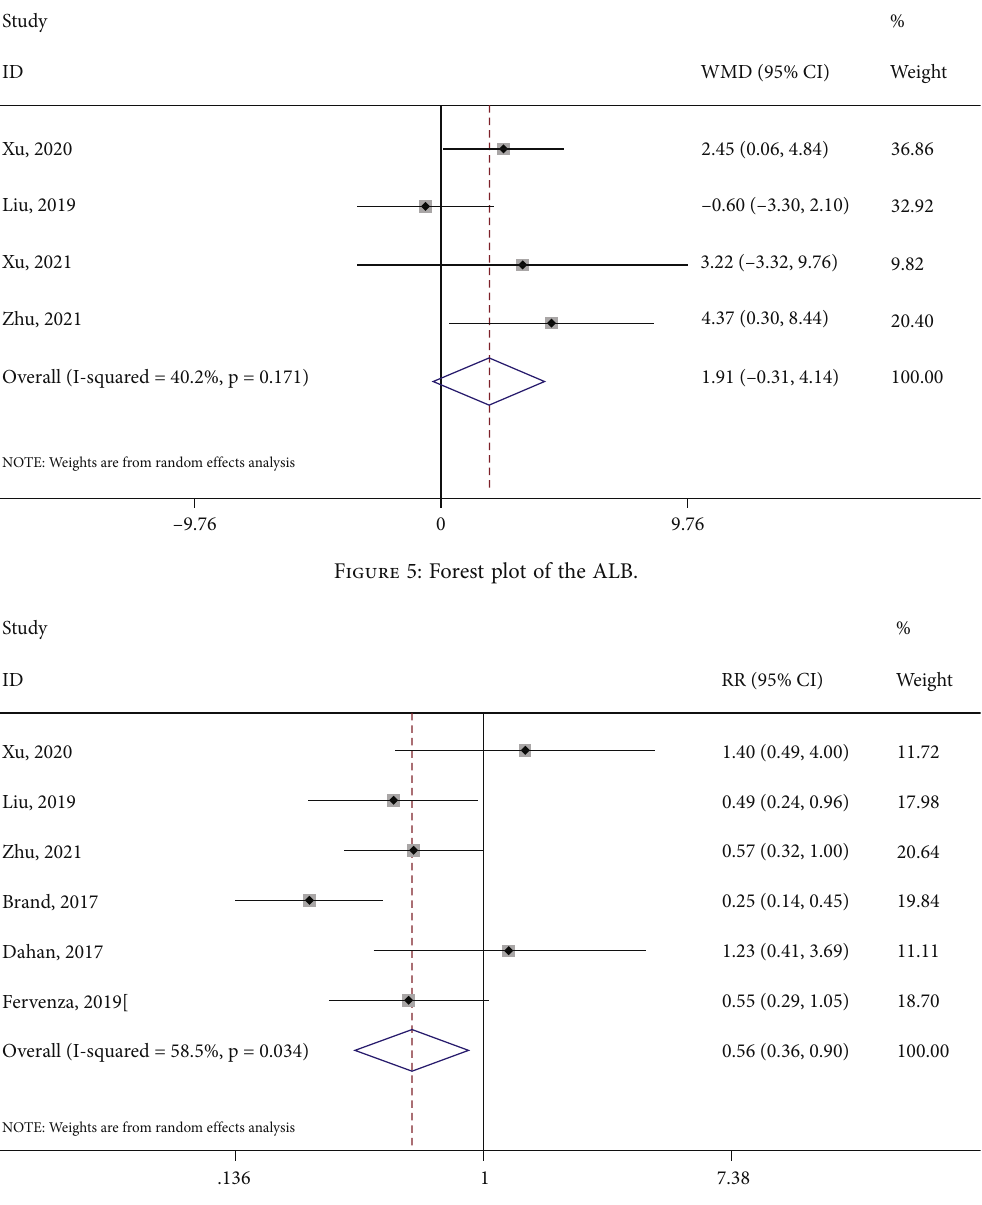
Figure 6: Forest plot of the adverse